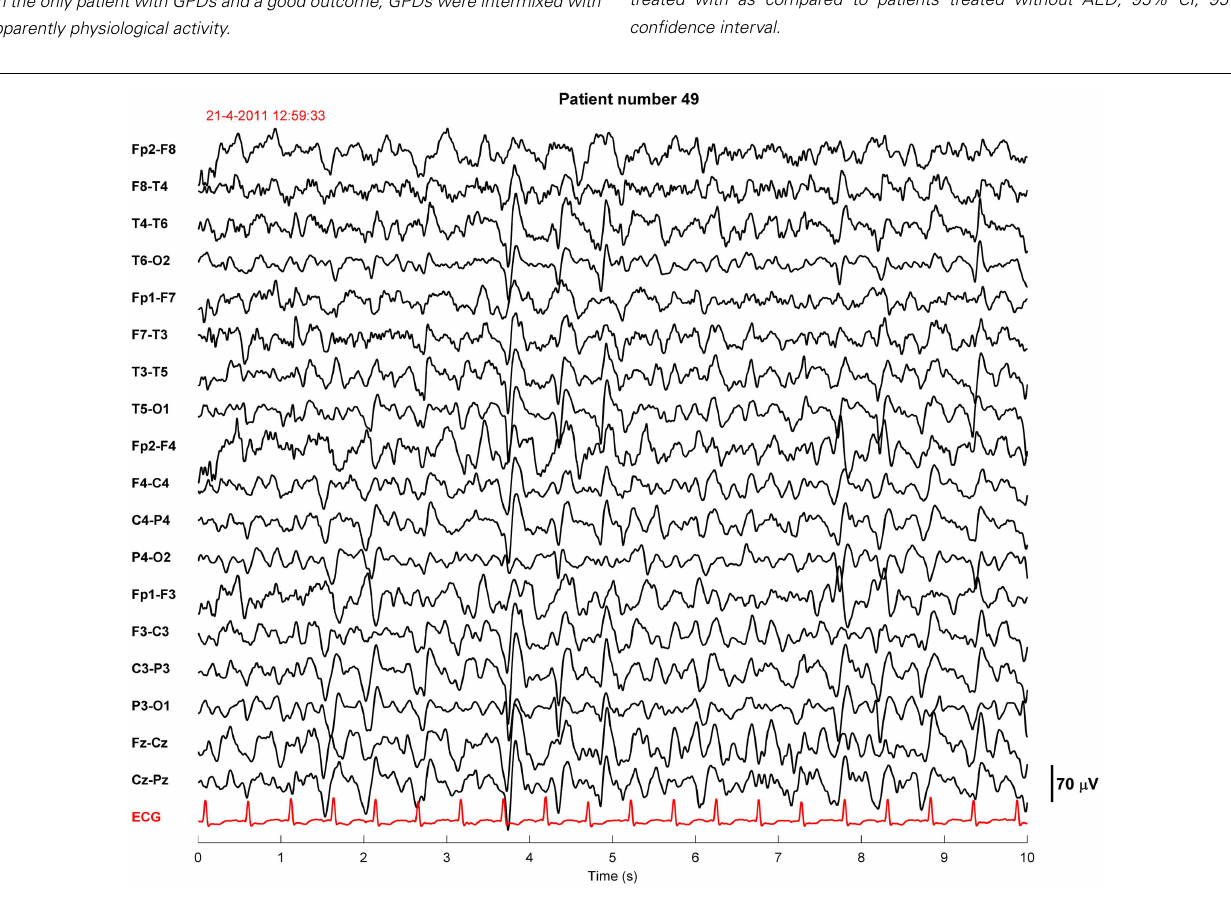
FIGURE 4 | Example of an EEG fragment of a comatose patient after cardiac arrest showing generalized periodic discharges intermixed with non-rhythmic activity .This patient was sedated with propofol 2.8mg/kg/h.